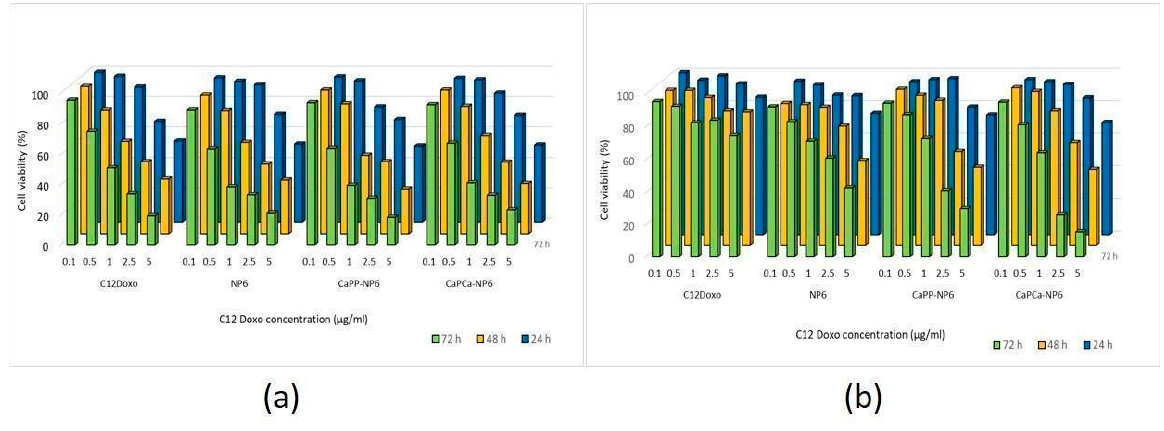
Figure 4. U-2OS ( a ) and U-2OS/DX ( b ) cells were incubated with NP6, CaP P -NP6, and CaP Ca -NP6, carrying 0.1, 0.5, 1, 2.5, or 5 µg/mL C12DOXO for 24, 48, and 72 h. Cell viability was measured using the MTT assay. Results are means ± SD ( n = 3). U-2OS, 24 h: p < 0.05 for CaP P -NP6 (1 µg/mL); p < 0.001 for C12DOXO, NP6, CaP P -NP6, and CaP Ca -NP6 (2.5 and 5 µg/mL). U-2OS, 48 h: p < 0.05 for C12DOXO, NP6, CaP P -NP6, and CaP Ca -NP6 (all concentrations); p < 0.001 for C12DOXO, NP6, CaP P - NP6, and CaP Ca -NP6 (all concentrations). U-2OS, 72 h: p < 0.01 for C12DOXO (0.5 µg/mL); p < 0.001 for C12DOXO, NP6, CaP P -NP6, and CaP Ca -NP6 (all concentrations). U-2OS/DX, 24 h: p < 0.05 for NP6 (5 µg/mL); p < 0.01 for NP6, CaP P -NP6, and CaP Ca -NP6 (5 µg/mL). U-2OS/DX, 48 h: p < 0.05 for NP6 (2.5 µ g/mL) and CaP Ca -NP6 1 µ g/mL); p < 0.001 for NP6 (5 µ g/mL), CaP P -NP6, and CaP Ca -NP6 (2.5 and 5 µ g/mL). U-2OS/DX, 72 h: p < 0.01 for NP6, CaP P -NP6, and CaP Ca